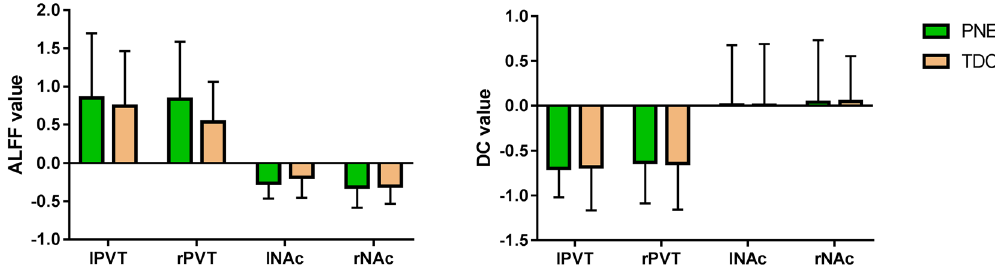
Figure 2. The comparison of ALFF and DC value of bilateral PVT and NAc.